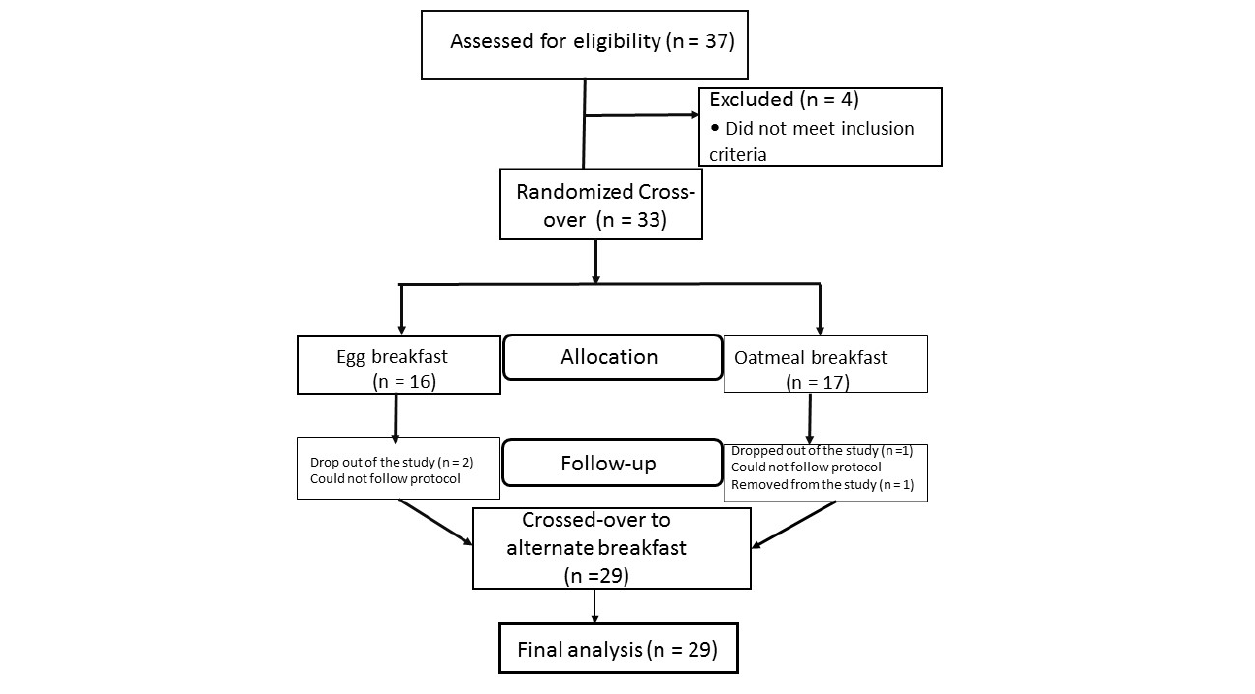
Figure 1. Flow chart of the study.